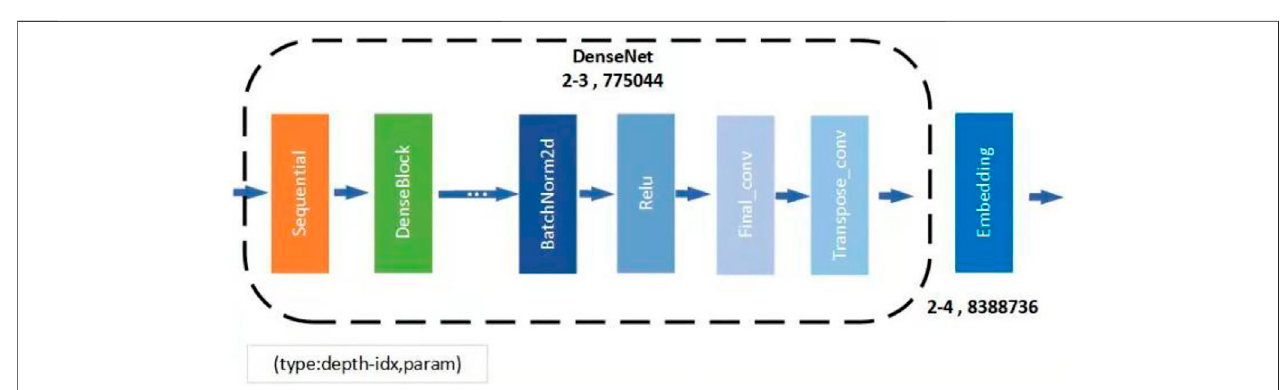
FIGURE 6 | Data preprocessing.